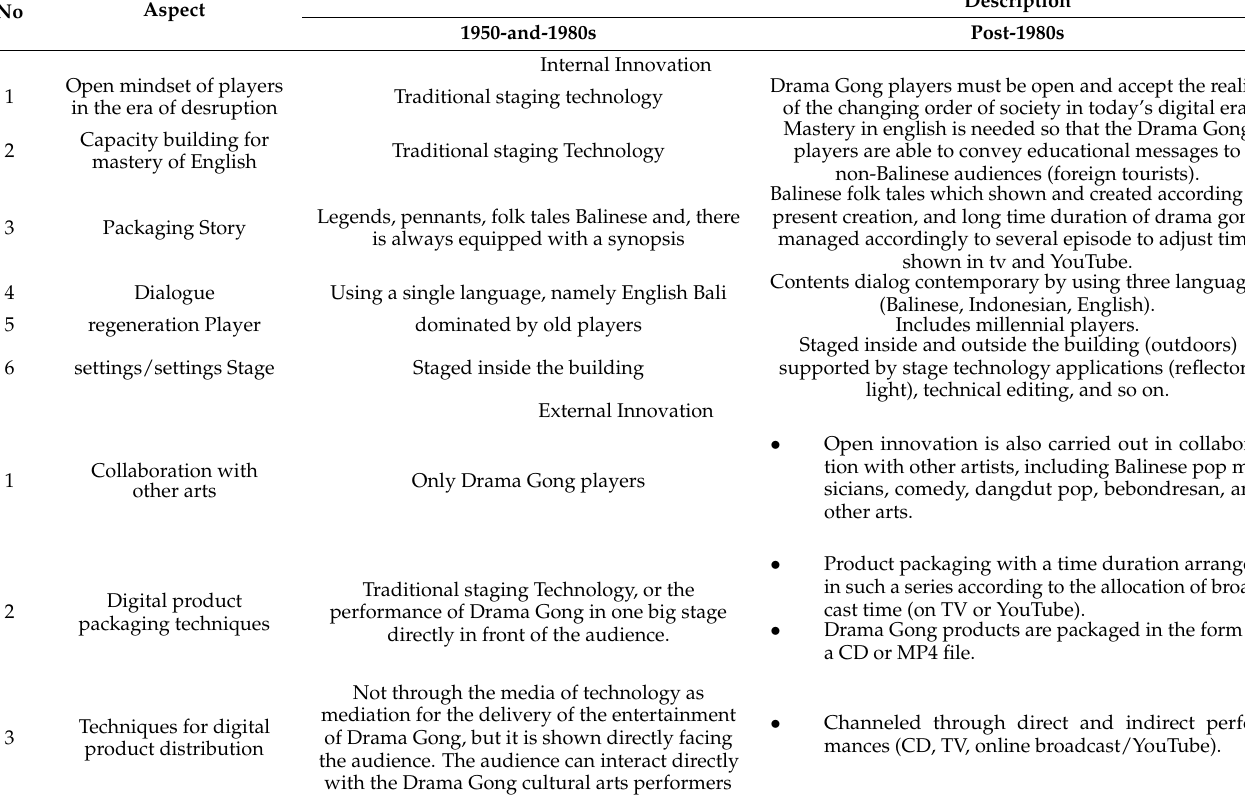
Table 1. The Open Innovation of Drama Gong performance at